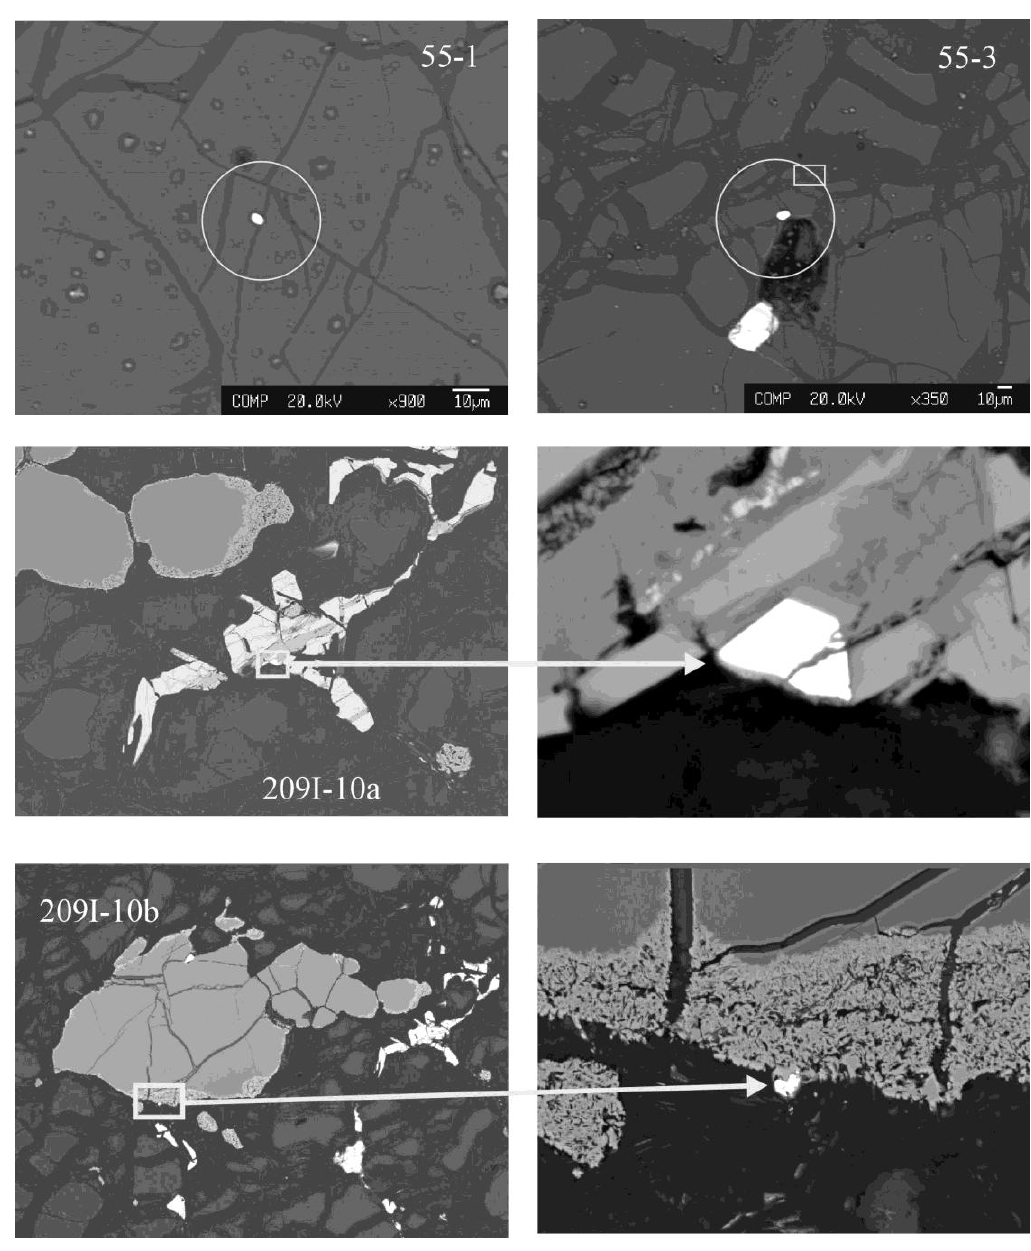
Figure 9. Paragenetic assemblages of PGM in the dunite adjacent to CHR-1 chromitite (BSE images). 55-1: Pt-Fe alloy included in opx; 55-2: Laurite in serpentine veins after olivine, in close proximity to pentlandite + native Cu after chalcopyrite (large grain); 209I-10a: Partially euhedral sobolevskite-kotulskite-sudburyite type PGM associated with pentlandite veined with magnetite, interstitial to serpentinized olivine and accessory chromite in dunite; 209I-10b: Composite grain of moncheite type and stumpflite type PGM attached to the rim of porous ferrian-chromite coating accessory chromite in